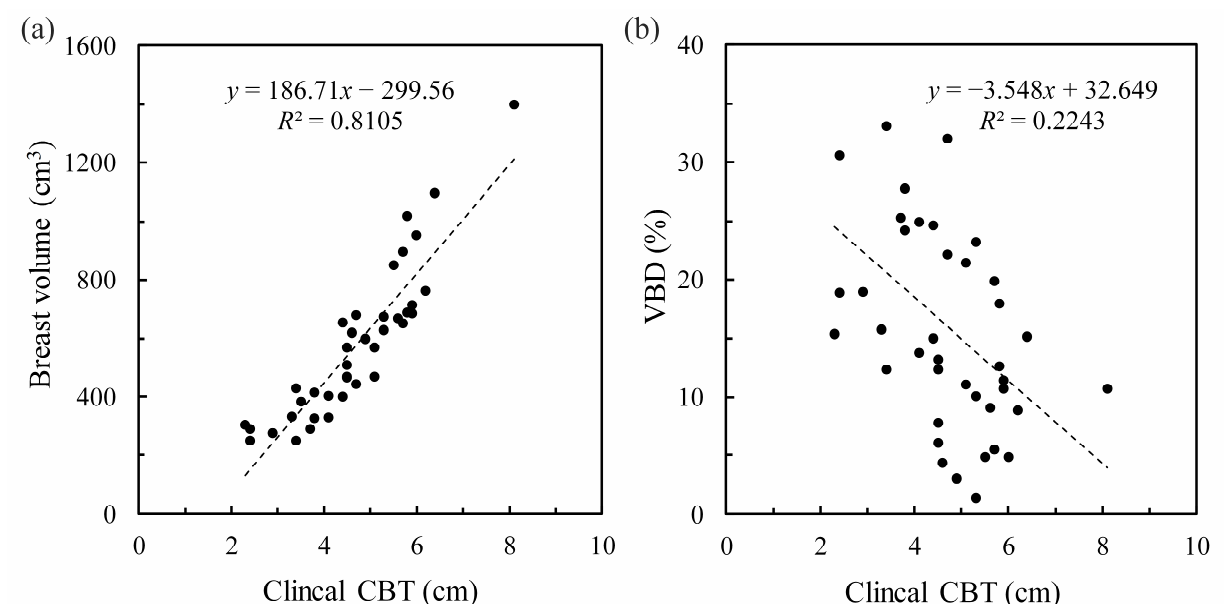
Figure 3. ( a ) Strong positive correlation between breast volume and clinical CBT ( r = 0.900) and ( b ) moderately negative correlation between VBD and clinical CBT ( r = − 0.474).